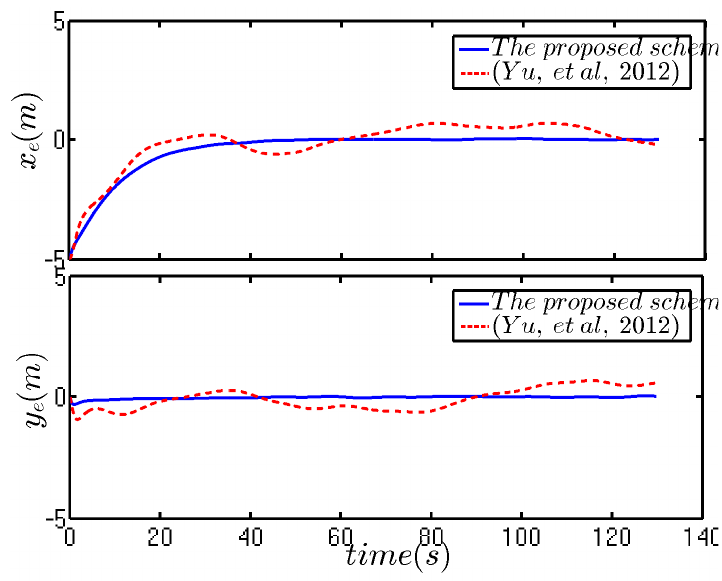
Figure 8. Comparison results of tracking